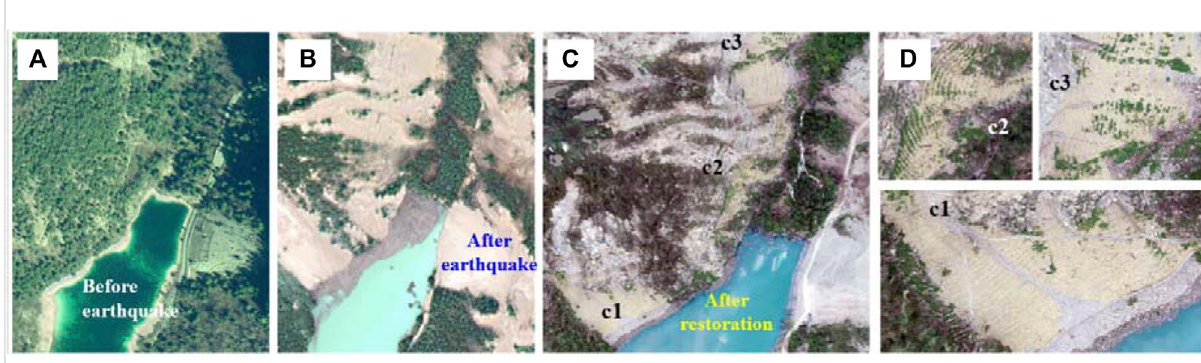
FIGURE 4 Panda Lake in the Jiuzhai World Natural Heritage Site before (A) the 2017 earthquake, just after the earthquake without any restoration (B) , and 3 years after the earthquake with restoration (C,D) . Note: all fi gures were taken by unmanned aerial vehicles; the image in panel b shows landslides triggered by earthquakes and their effects on water quality and the original aquatic ecosystem; the image in panel d shows enlarged areas of the vegetation restoration region shown in panel c, which was taken in June 2020.